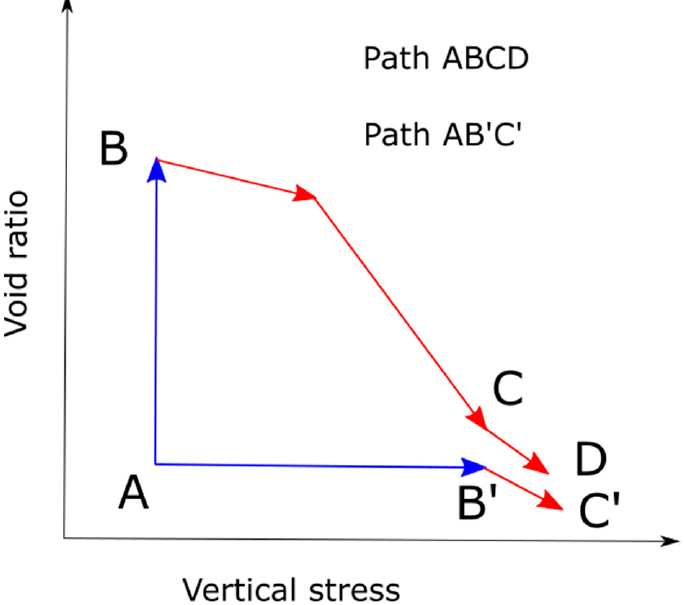
Figure 1. Schematic view of the experiment stages: Path AB’C’: hydration under confined volume conditions and subsequent compression. Path ABCD: hydration under free swell conditions and subsequent compression, adapted from [36].